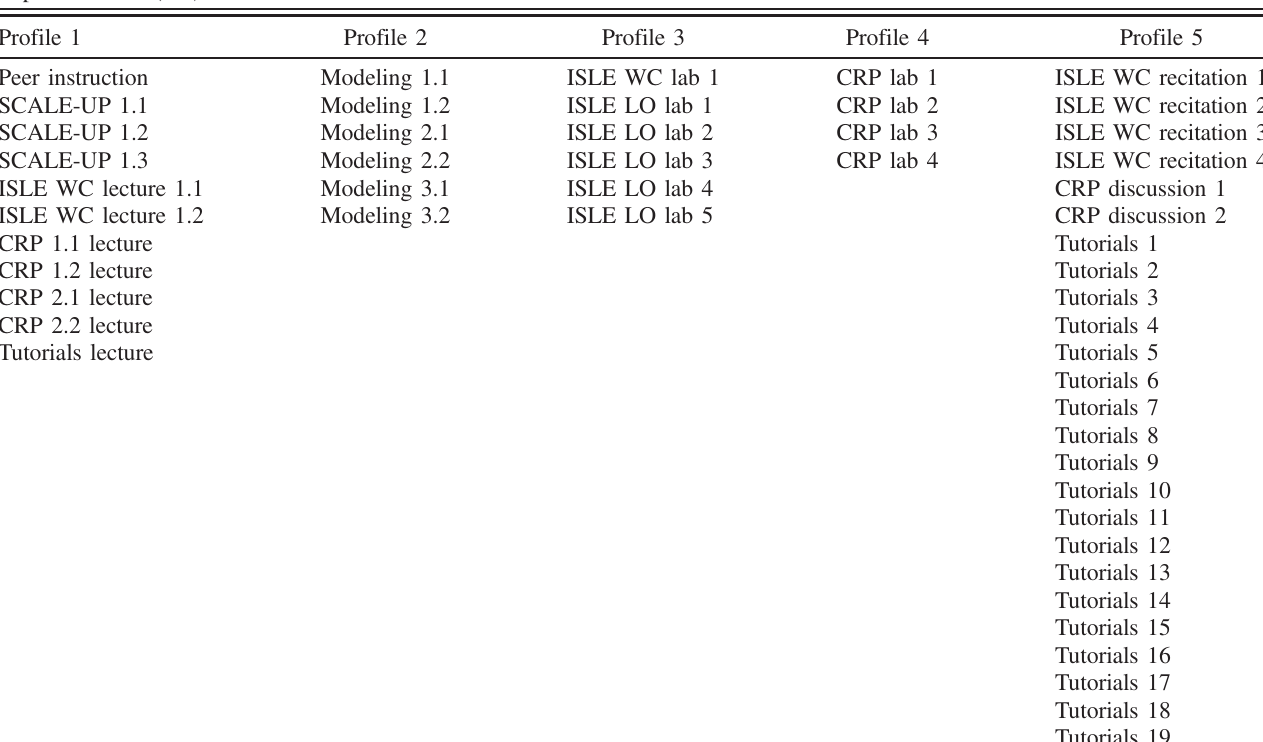
TABLE VI. Model 1 profile assignment, 5 profile. Profile 1 is red in the lower panel in Fig. 3, profile 2 is blue, profile 3 is green, profile 4 is purple, and profile 5 is orange. ISLE had two sets of observations, the whole-class implementation (WC) and the lab-only implementation